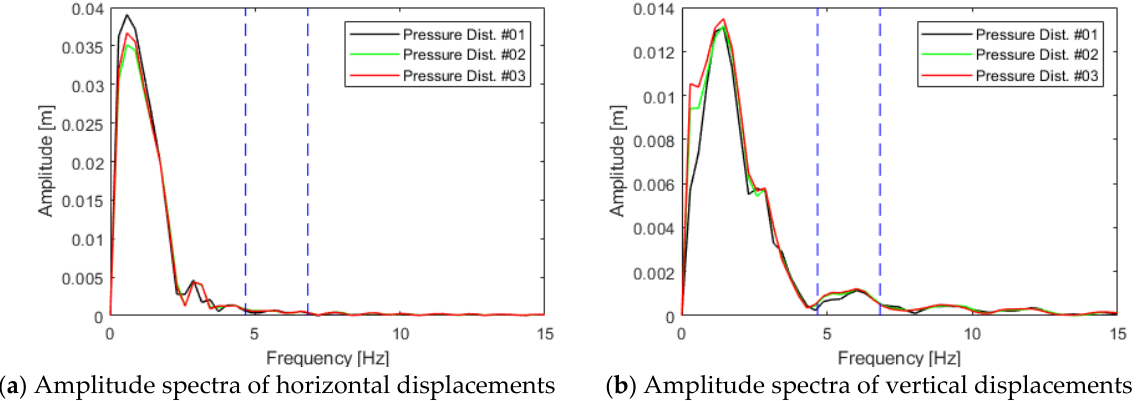
Figure 9. Amplitude spectra of horizontal and vertical displacements.